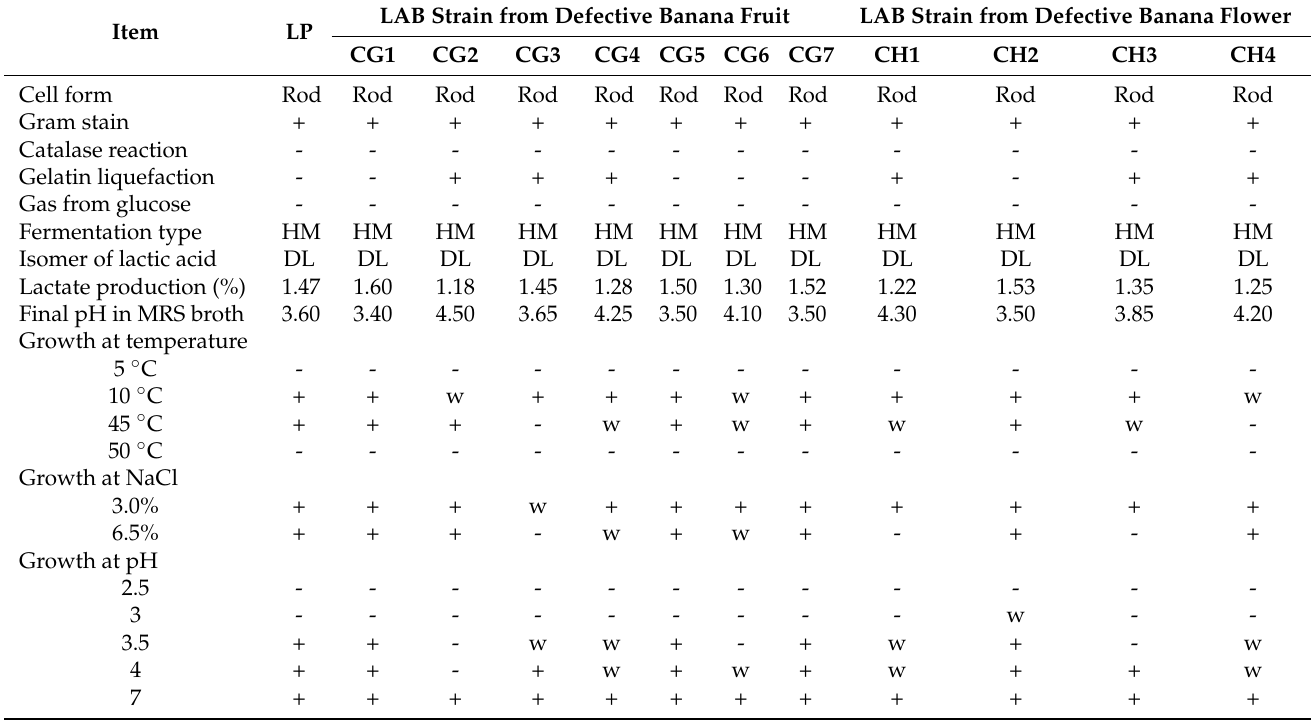
Table 1. Physiological and biochemical characteristics of lactic acid bacteria (LAB) strain isolated from defective